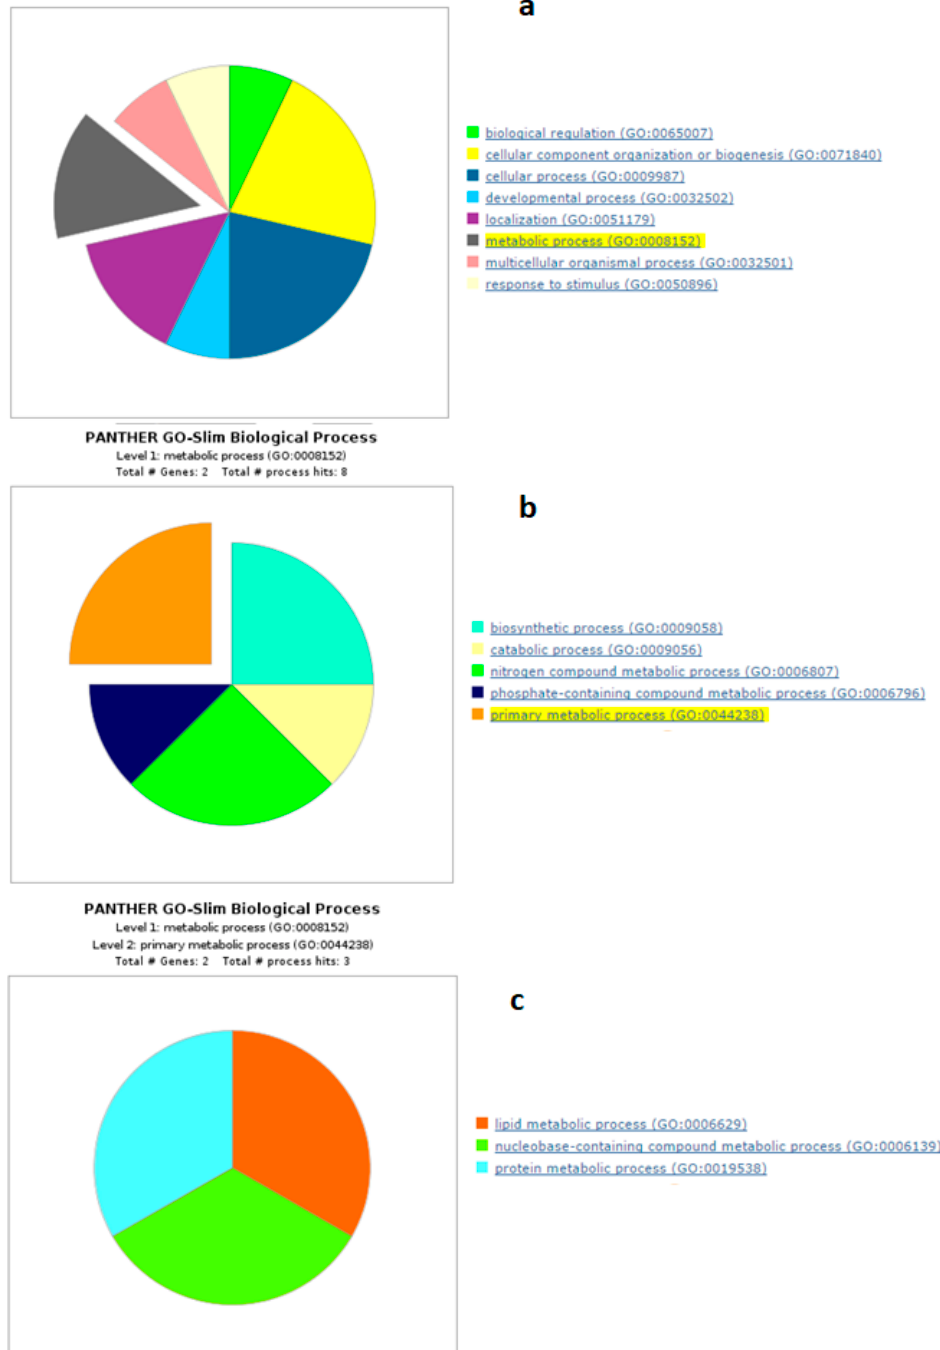
Figure 7. Functional classification of overrepresented proteins among all time points between sNEB and lNEB with the enrichment of most represented processes up to the primary metabolic process. ( a ) Biological process, ( b ) metabolic process, ( c ) primary metabolic process.